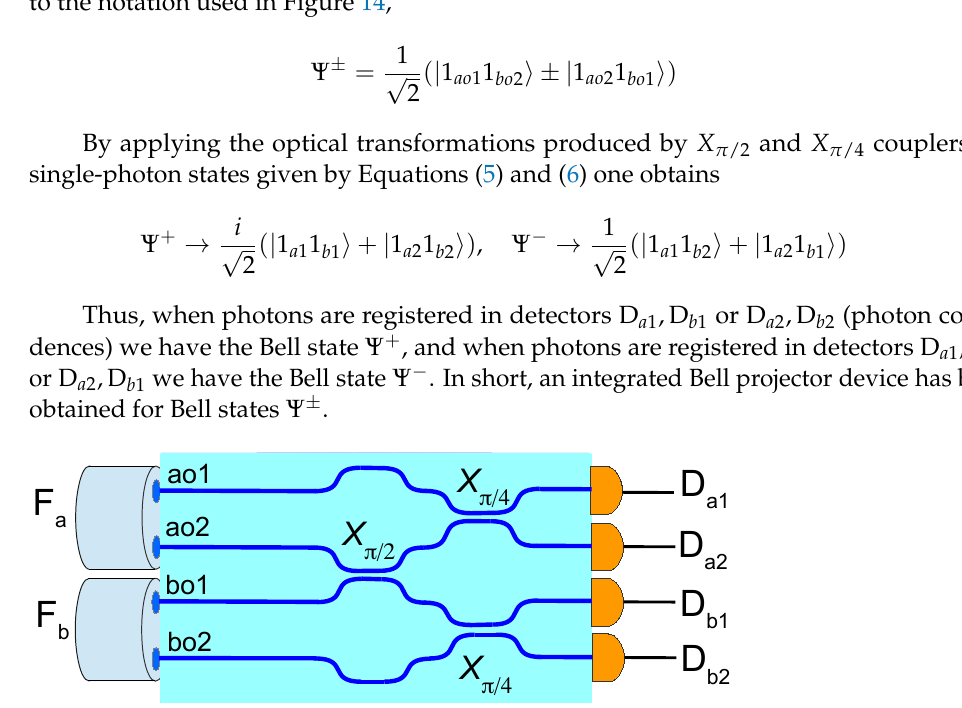
Figure 14. Integrated Bell projector for entangled quantum states excited in four cores ao j , j = 1,2,3,4 of two-core optical fibers F a and F b . Detectors D aj are used for measuring photon